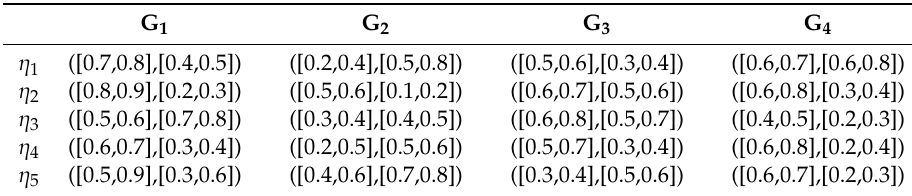
Table 1. The q-RIVOFNs information given by D 1 .